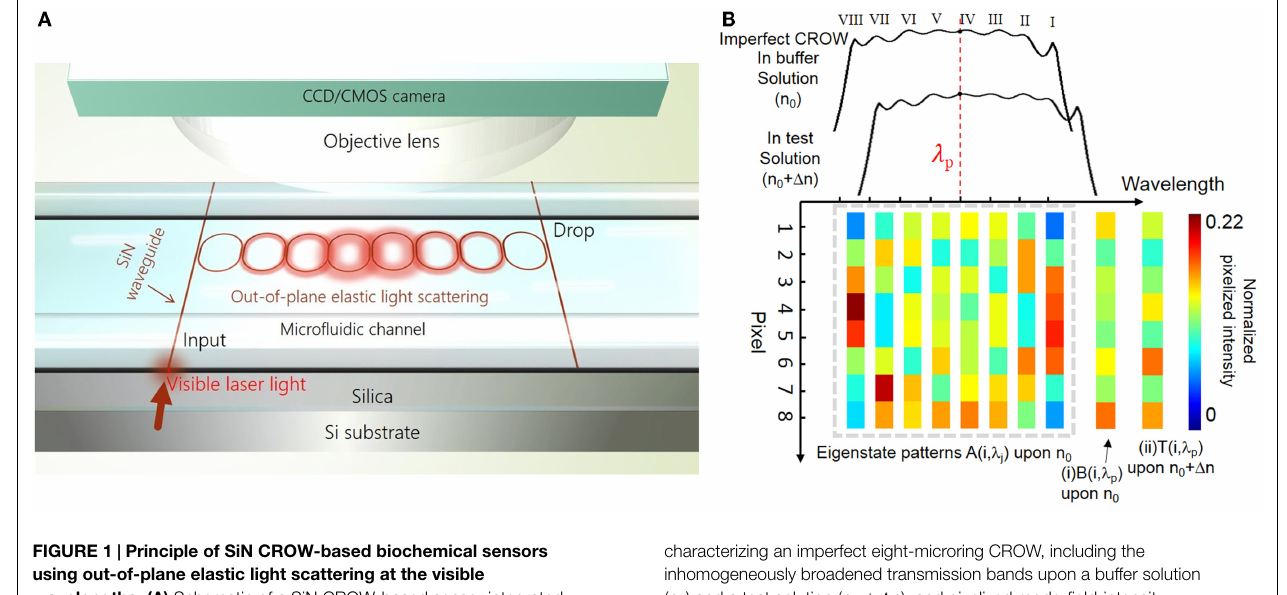
FIGURE 1 | Principle of SiN CROW-based biochemical sensors using out-of-plane elastic light scattering at the visible wavelengths . (A) Schematic of a SiN CROW-based sensor integrated with a microfluidic channel. An objective lens and a CMOS/CCD camera are applied on top of the optofluidic chip in order to image the out-of-plane elastic-light-scattering pattern. (B) Illustration of